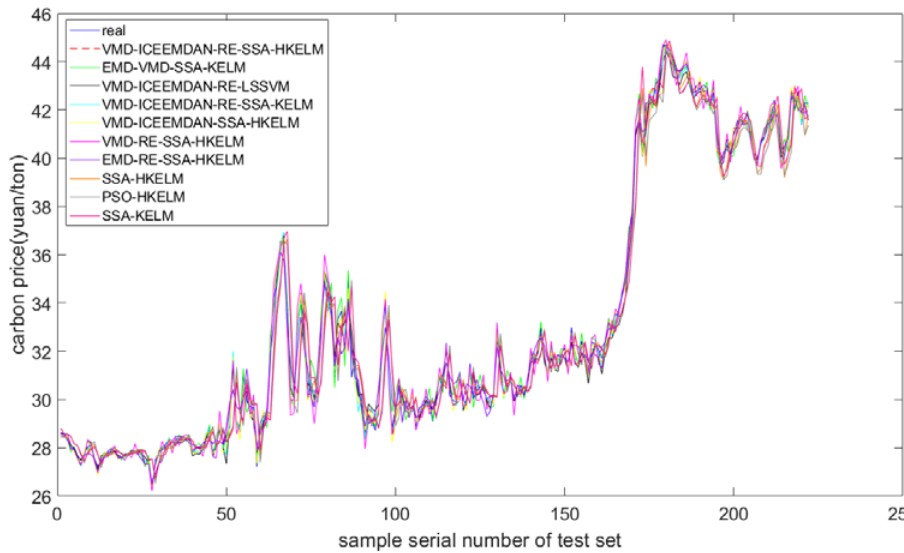
Figure 5. Results of the predicted carbon prices in the Hubei market. Table 6. Comparison of the models in forecasting carbon prices in the Hubei market.